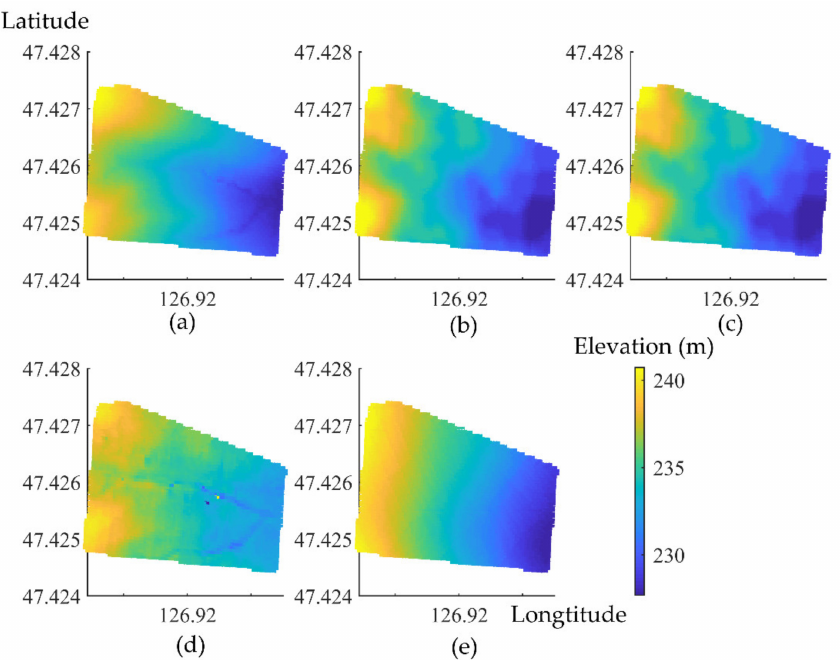
Figure 8. Comparisons of DEMs at site 3: ( a ) UAV DEM; ( b ) SRTM DEM; ( c ) SRTM_Low Pass Filter; ( d ) Improved SRTM and ( e )